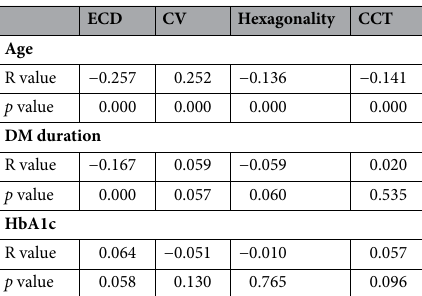
Table 3. Correlations between endothelial cell parameters and age, diabetic duration, and HbA1c% in the diabetic group. ECD Endothelial cell density, CV Coefficient of variation, CCT Central corneal thickness. p value by Pearson’s correlation coefficient